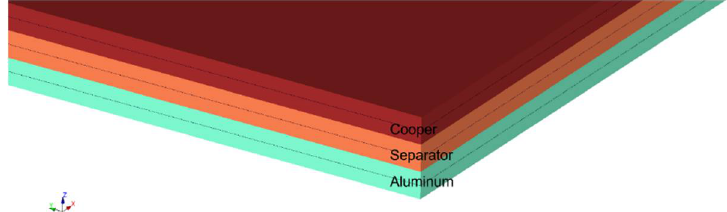
Figure 6. Numerical jelly roll model subjected to tensile test.